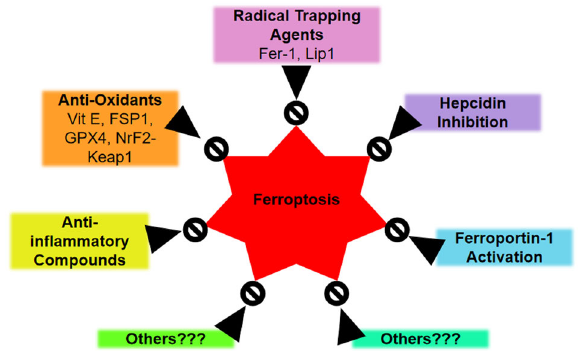
Fig. 4 Illustration of possible therapeutic intervention targets to control ferroptosis induced accelerated aging. Besides the currently known classes of ferroptosis inhibitors such as radical trapping agents, anti-oxidants, anti-in fl ammatory agents, hepcidin inhibitors and ferropotin-1 activators, still there is a need of effective anti-ferroptotic compounds that could be used to prevent accelerated and debilitated